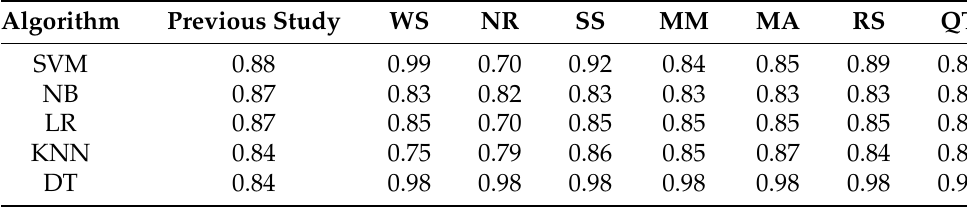
Table 14. Comparison of F1 score with previous study done by Amin et al. (2019)